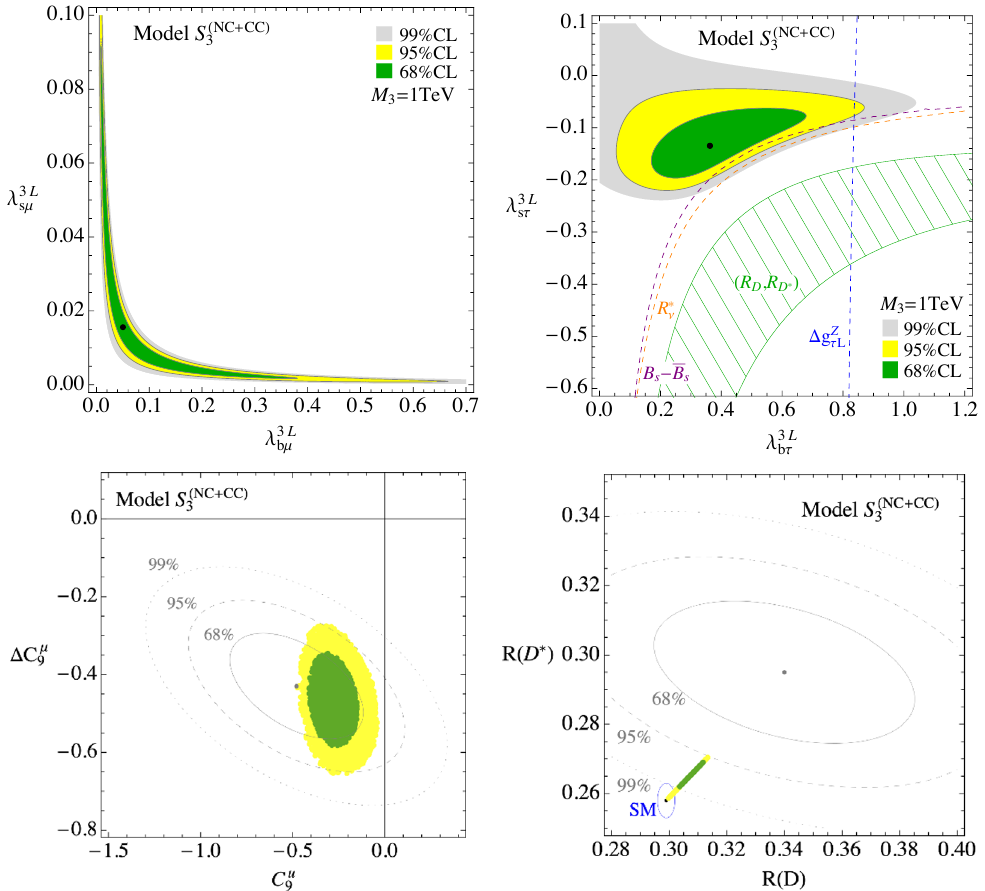
Figure 4 . Result from the fit in the S 3 model. In the upper panels we show the preferred regions in the planes of two couplings, where the two not shown are profiled over. The dashed lines show, for illustrative purposes, 2 σ limits from individual observables where the other couplings are fixed at the best-fit point (black dot). In the lower panels we show where the preferred region is mapped in the planes of the neutral and charged-current